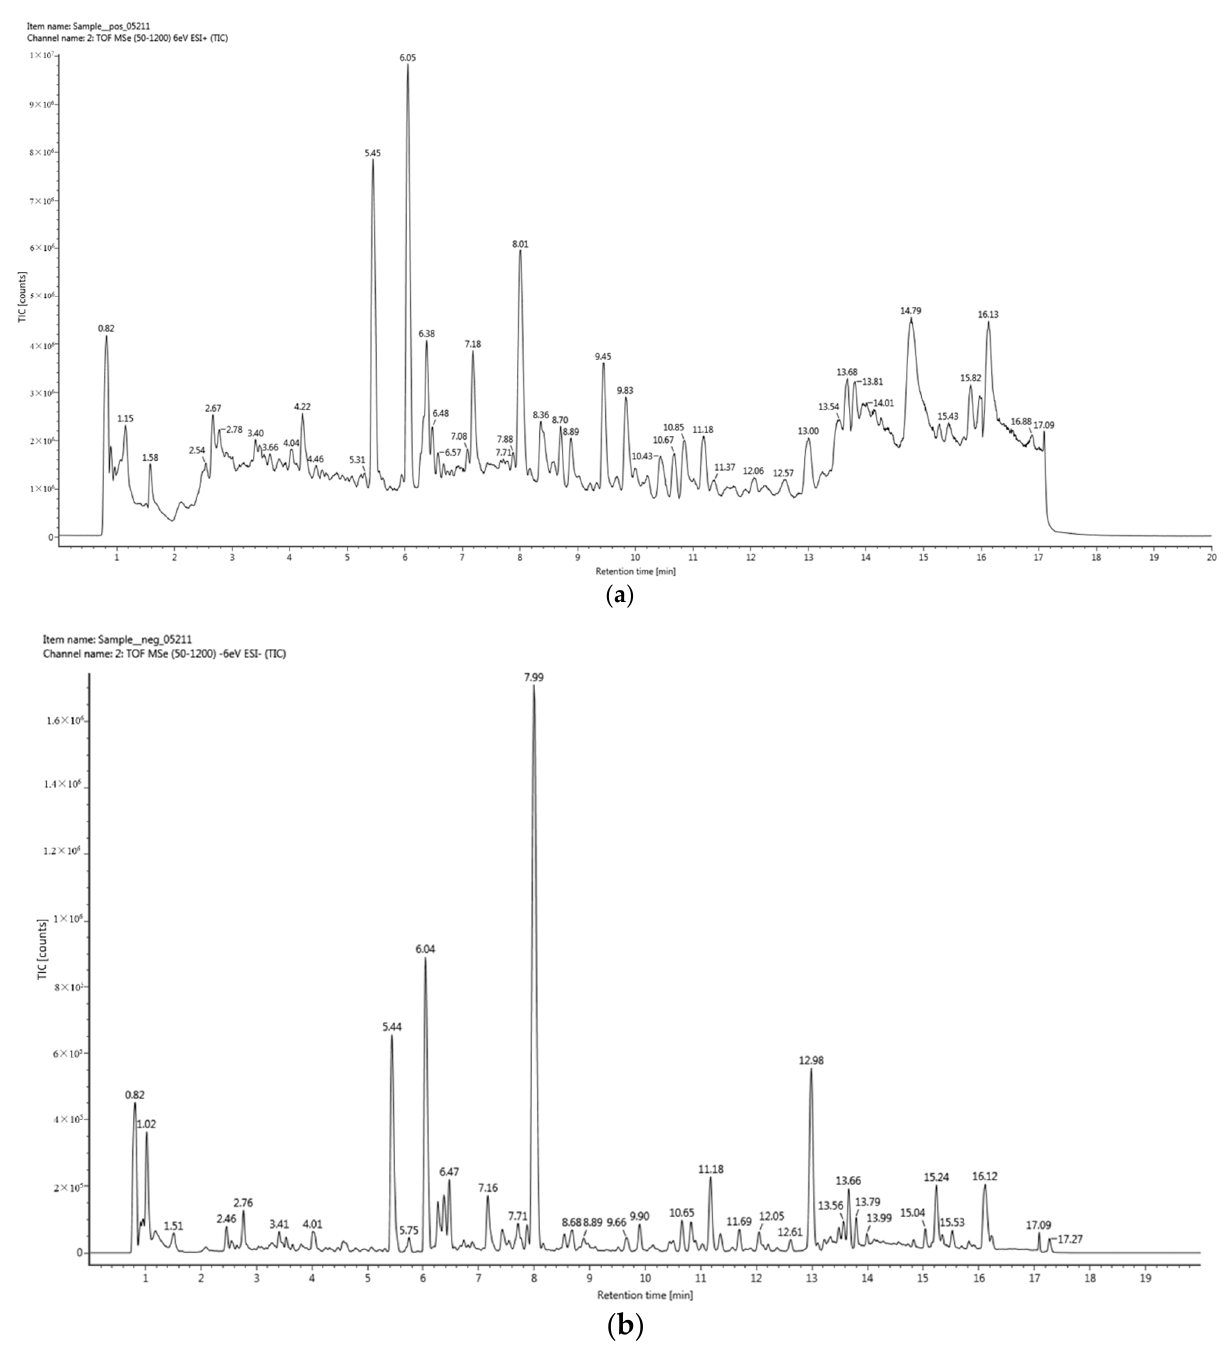
Figure 3. Example of total obtained ion chromatogram of L09-1 germ substrate sample using UPLC-QTOF-MS E in positive mode ( a ) and negative mode ( b ).